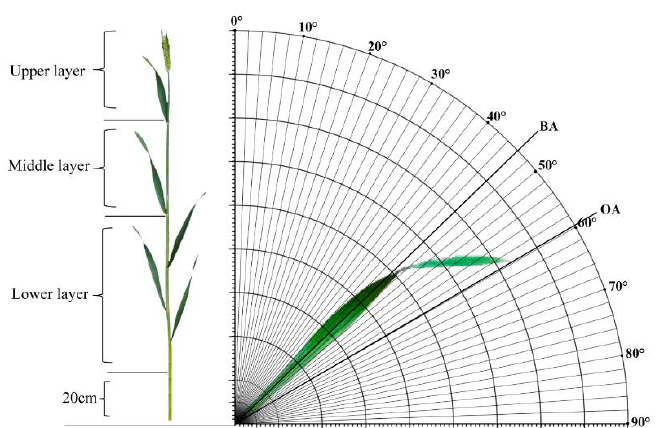
Figure 2. Canopy layer and leaf angle. BA: base angle. OA: open angle.